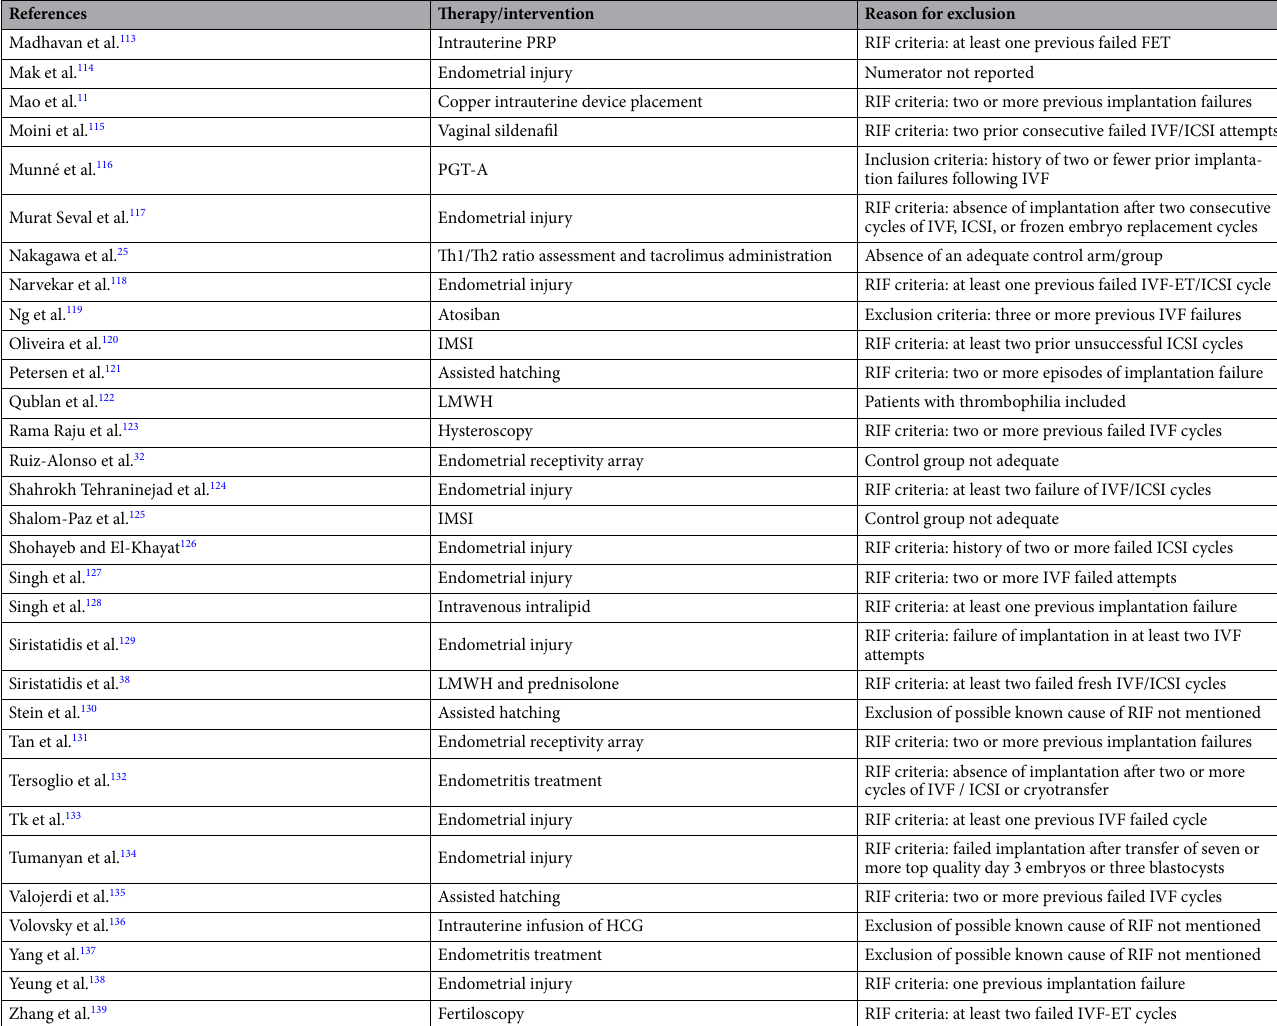
Table 1. Reasons for exclusion of observational studies. PRP platelet rich plasma, RIF repeated implantation failure, IVIG intravenous immunoglobulin, IVF in vitro fertilization, IMSI intracytoplasmic